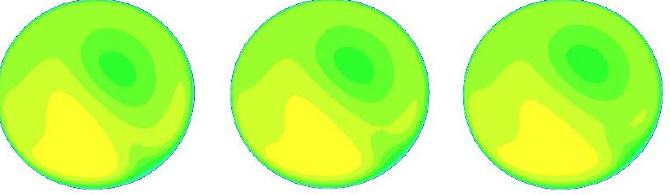
Figure 5. Velocity cloud diagrams at 2, 4, and 6 m/s at x = 50 cm (from left to right).